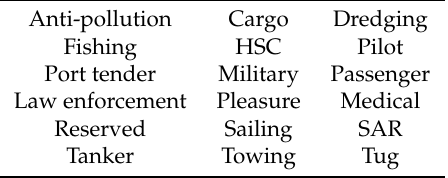
Table 1. Ship types provided by the Automatic Identification System